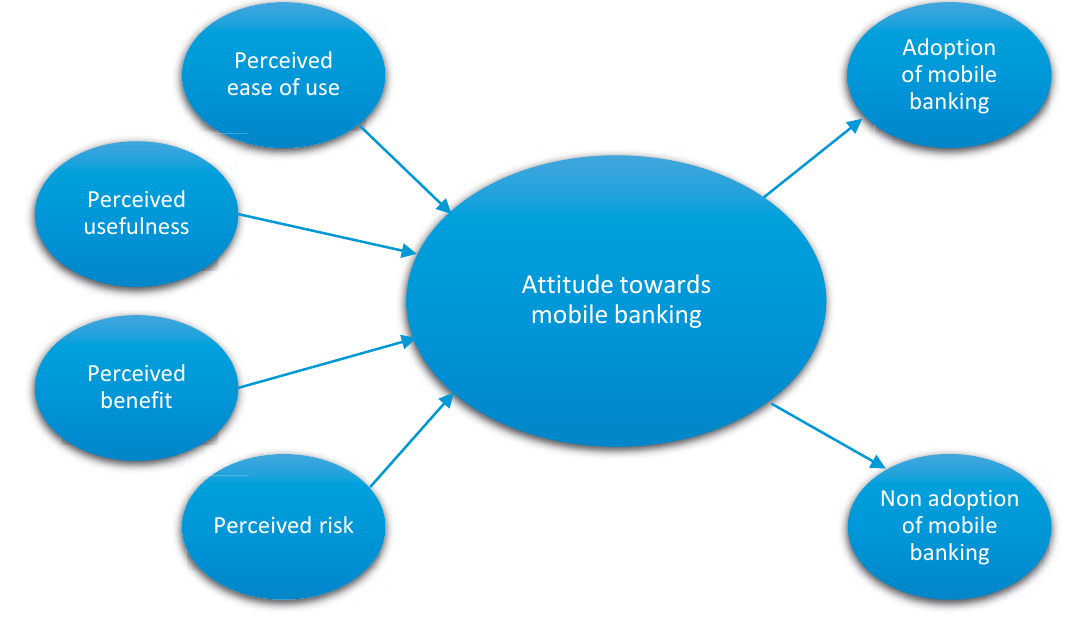
Figure 1. Table 1. (cid:38)(cid:258)(cid:272)(cid:410)(cid:381)(cid:396)(cid:3)(cid:258)(cid:374)(cid:258)(cid:367)(cid:455)(cid:400)(cid:349)(cid:400)(cid:3)(cid:381)(cid:374)(cid:3)(cid:400)(cid:286)(cid:396)(cid:448)(cid:349)(cid:272)(cid:286)(cid:400)(cid:3)(cid:396)(cid:286)(cid:400)(cid:393)(cid:381)(cid:374)(cid:282)(cid:286)(cid:374)(cid:410)(cid:400)(cid:3)